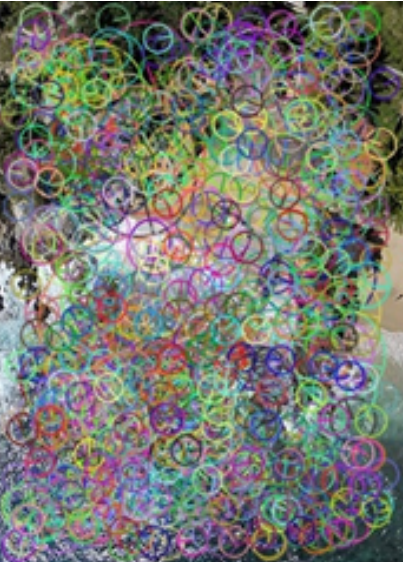
Figure 4. K-ranked SURF geometrical centroid Figure 5. SURF points extracted from a sample image of